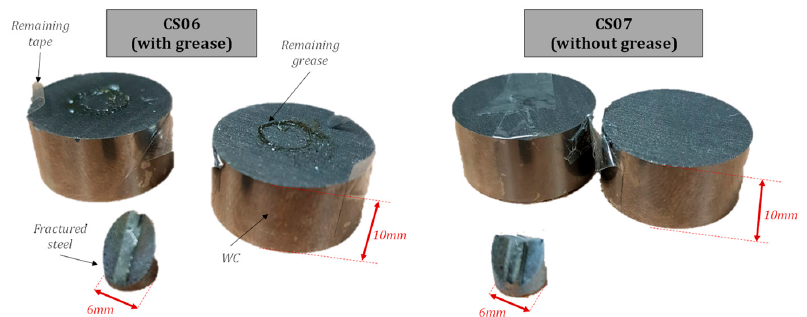
Figure 10. Post-test photographs of samples subjected to quasi-static SCS experiments. Test with grease ( CS06 ): a single inclined fracture plane is noted. Test without grease ( CS07 ): the fracture surface is composed of two inclined planes.